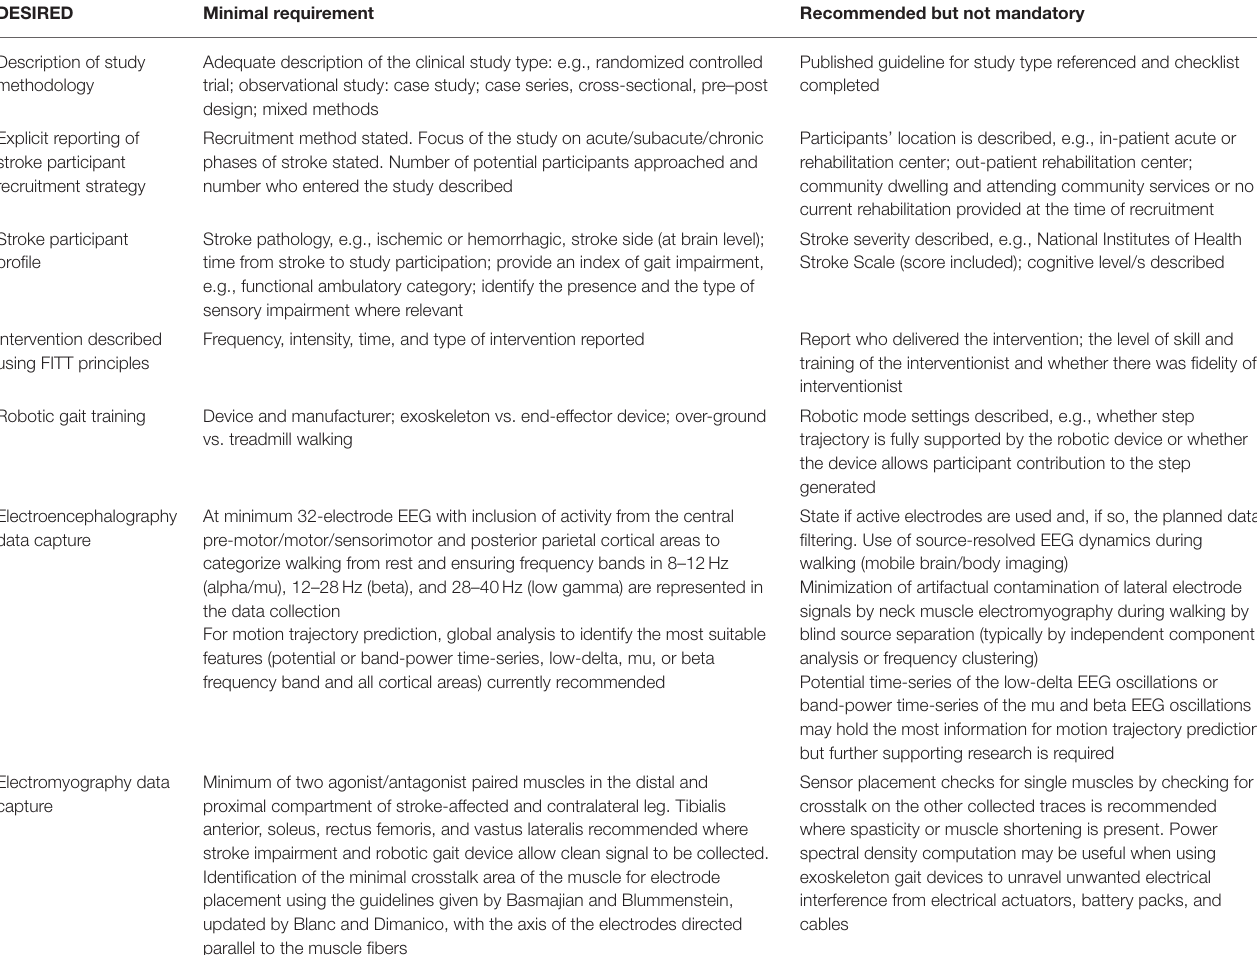
TABLE 6 | The DESIRED checklist: minimal reporting dataset for neural biosignals during robotic gait after a stroke. DESIRED Minimal requirement Recommended but not